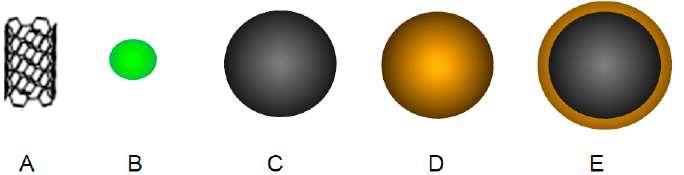
Figure 6. Schematic representation of inorganic nanoparticles: ( A ) Carbon nanotube; ( B ) Quantum dot; ( C ) Iron oxide; ( D ) gold and ( E ) iron oxide-gold.